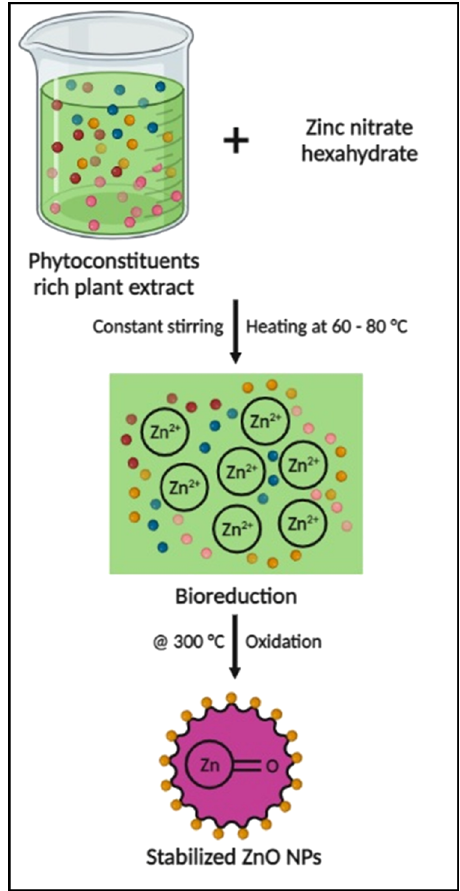
Figure 4: Plausible mechanism involved during the formation of ZnO NPs from the aqueous extract of S. acuta .